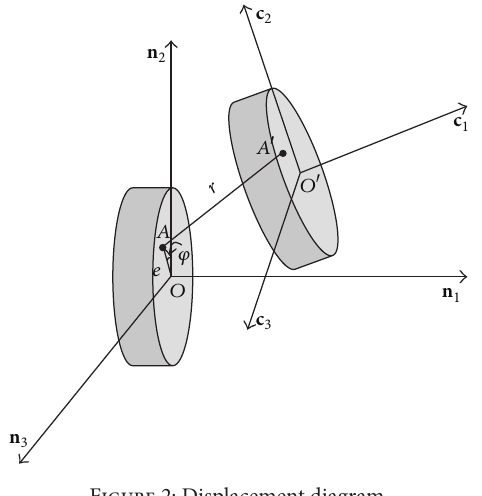
Figure 2: Displacement